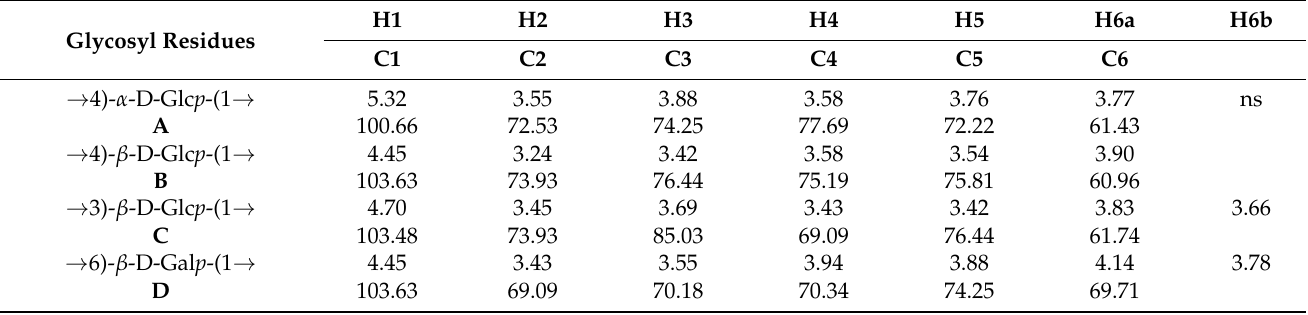
Table 3. 13 C and 1 H NMR chemical shifts (ppm) for